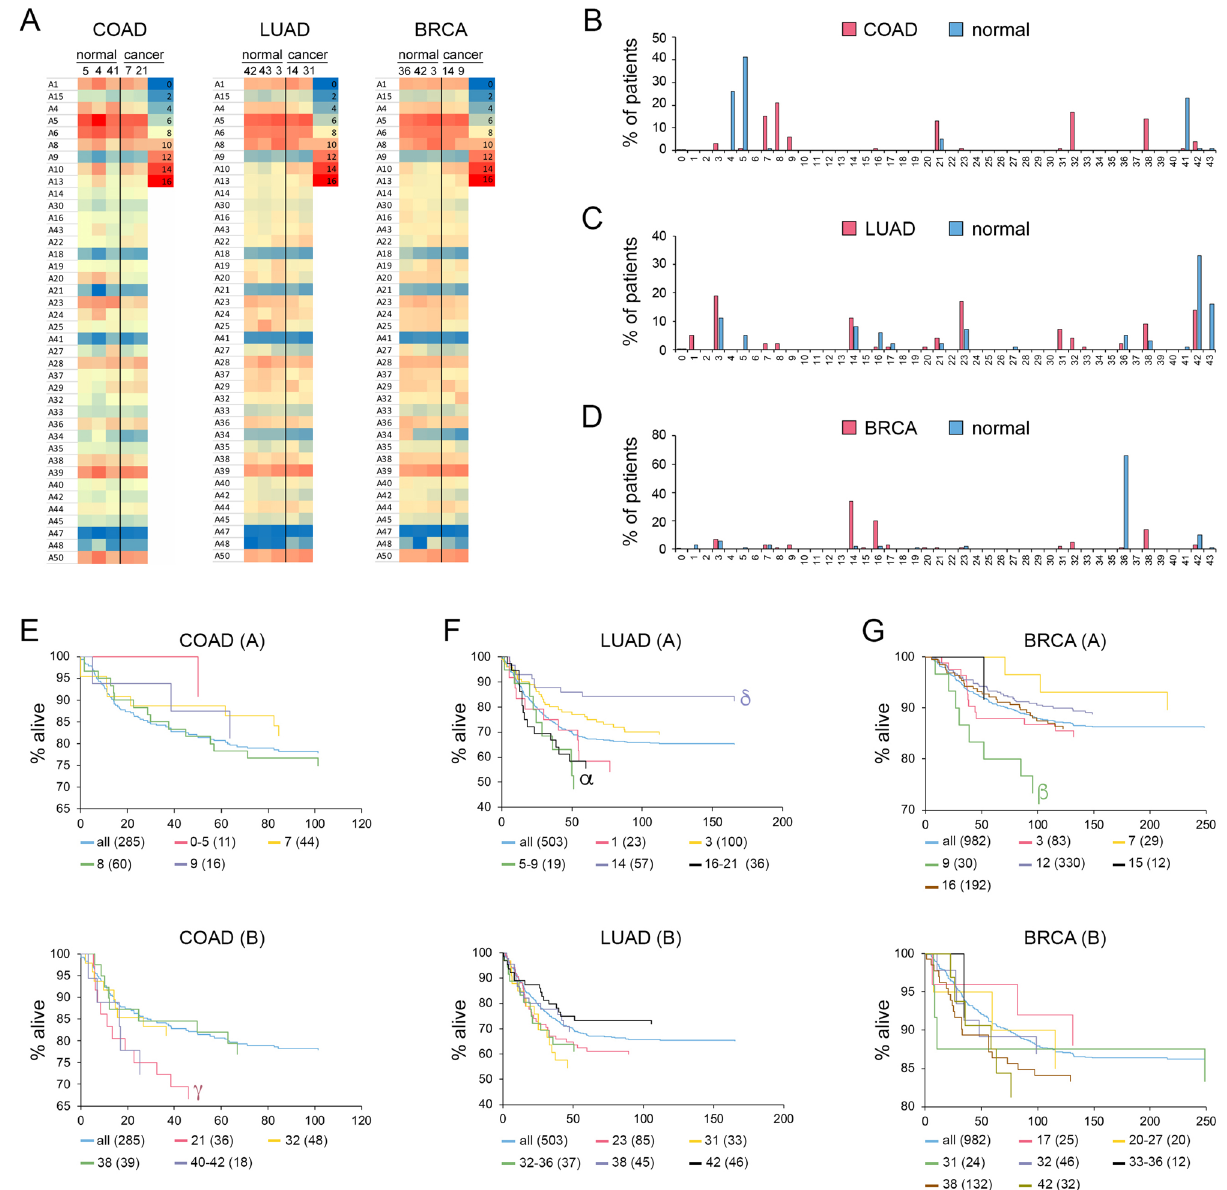
Figure 4. SLC25 expression of cancer types and matched normal tissue. COAD (n = 285); LUAD (n = 503); BRCA (n = 982). ( A ) Heat maps of gene expression of the indicated clusters of tumor and normal tissue L26-S24 SLC25 transporters. ( B – D ) Distribution of cancer and normal patients among SLC25 expression clusters. ( E – G ) Kaplan–Meier plots of patients grouped by SLC25 expression cluster. ‘all’ refers to total number of patients with the cancer type. Number in parenthesis is the number of patients within cluster or group of clusters used. Statistical analysis between survival of patients of SLC25 expression cluster(s) and the total patient population of the cancer type. α = p < 0.05; β = p < 0.025; γ = p < 0.02; δ = p < 0.01; ε = p <